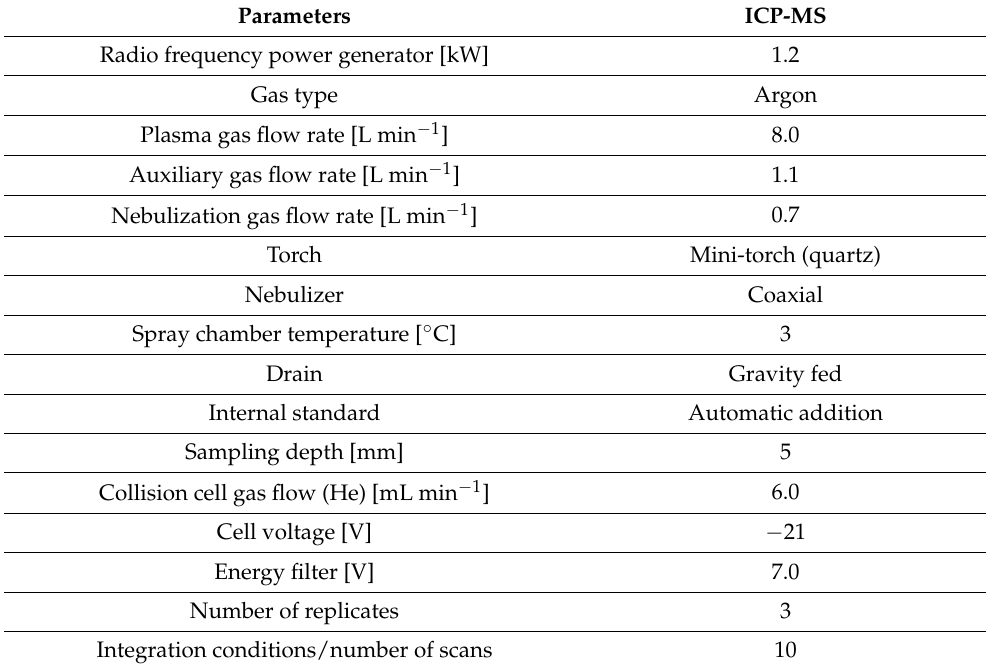
Table 1. ICP-MS measurement